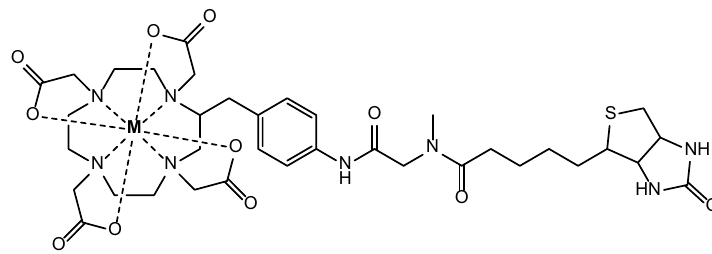
149 Pm, 166 Ho, 177 =